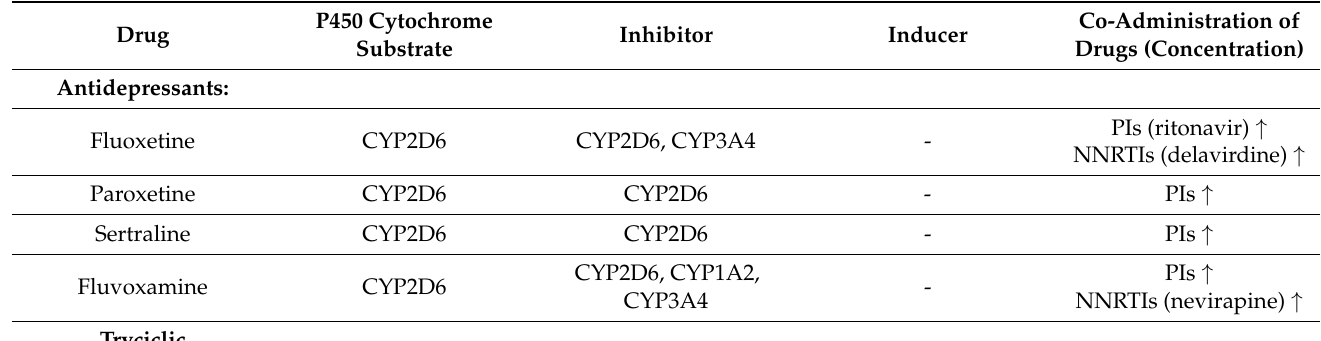
Co-Administration of Drugs